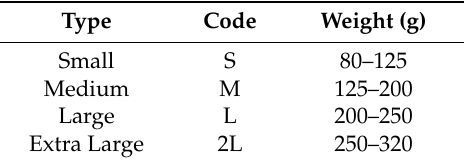
Table 4. Confusion matrix of mass prediction through an estimated volume.